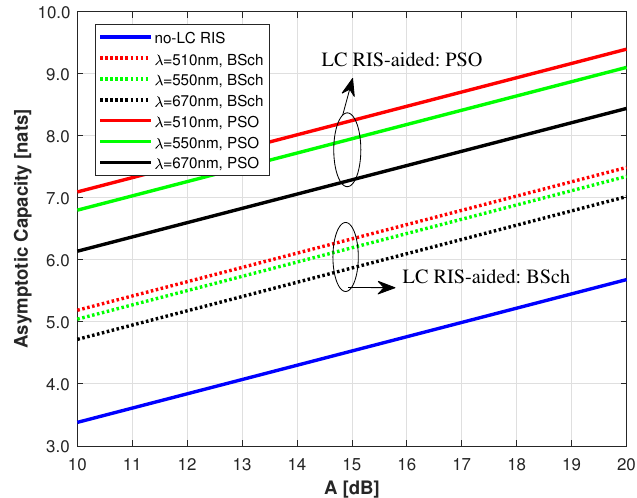
Figure 6. Asymptotic capacity versus SNR with different